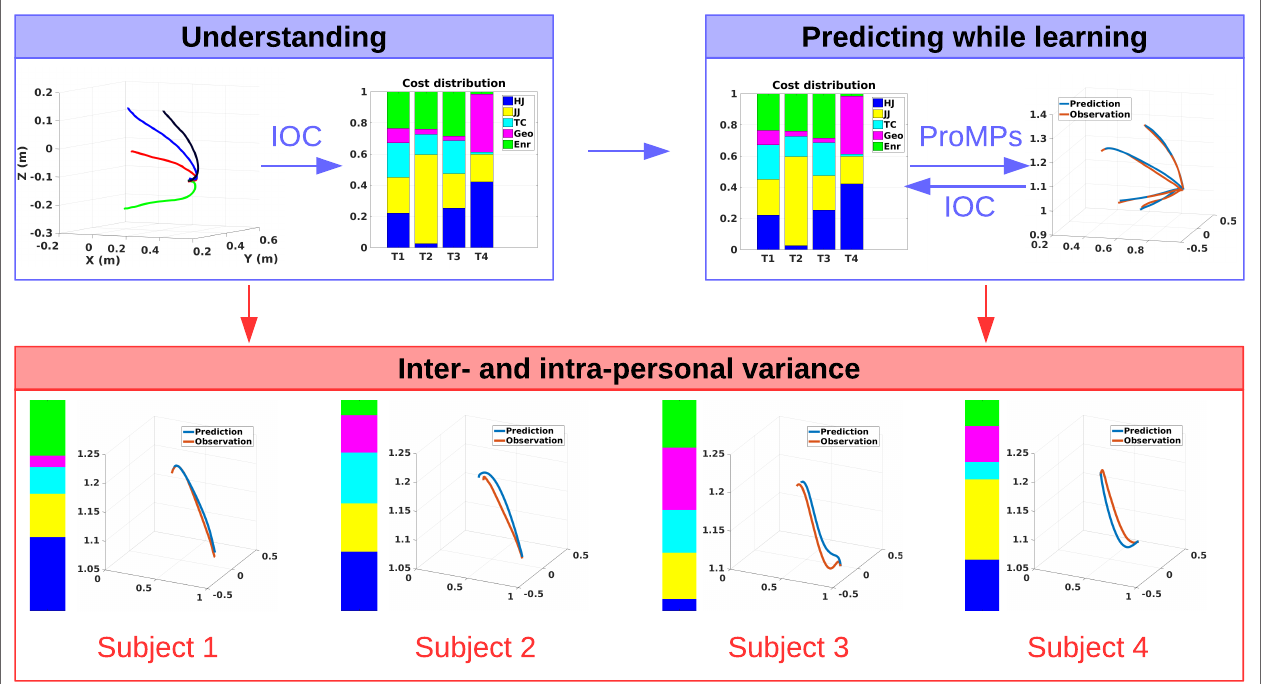
FIGURE 1 | The overall framework, where the focus is twofold: understanding (upper left) and prediction (upper right) of human motion behaviors. For understanding, biomechanically inspired cost function distributions are learned from demonstrations by model-based inverse optimal control; and for online prediction, data-driven probabilistic movement primitives are used. The two approaches are interconnected to each other in order to account for the inter-and intra-personal movement behavior variations in terms of both motion trajectories and also the cost distributions.